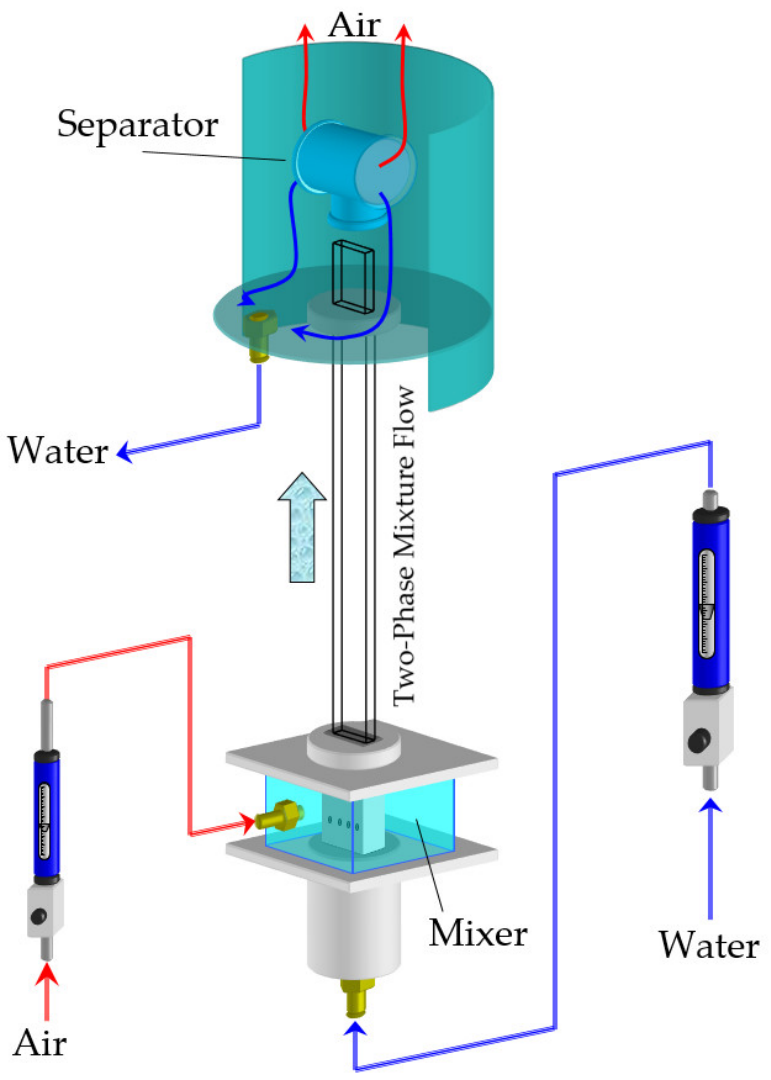
Figure 3. Schematic view of the measurement setup with the air/water inlet, air/water mixing chamber, rectangular measurement channel, air/water separator.